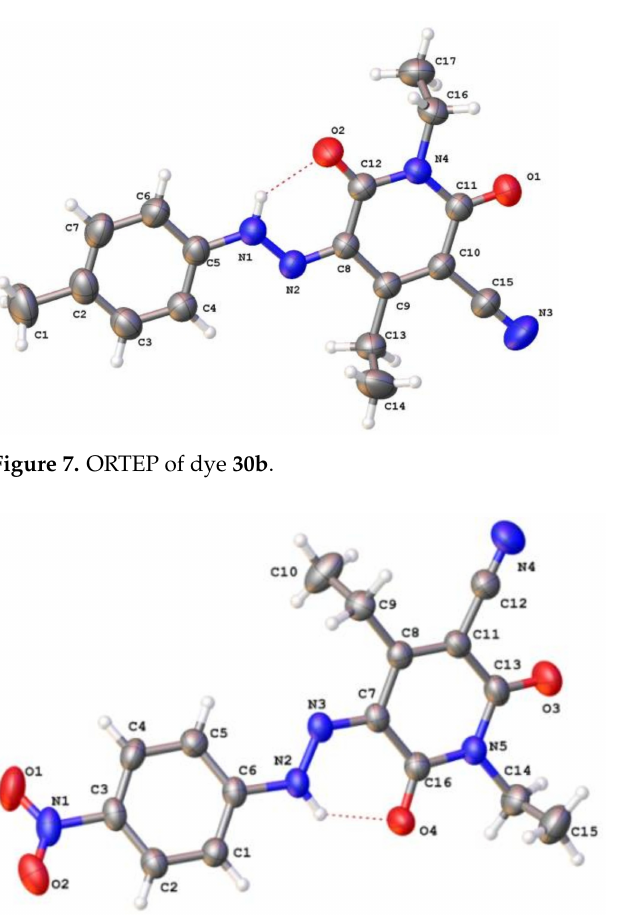
Figure 8. ORTEP of dye 30g